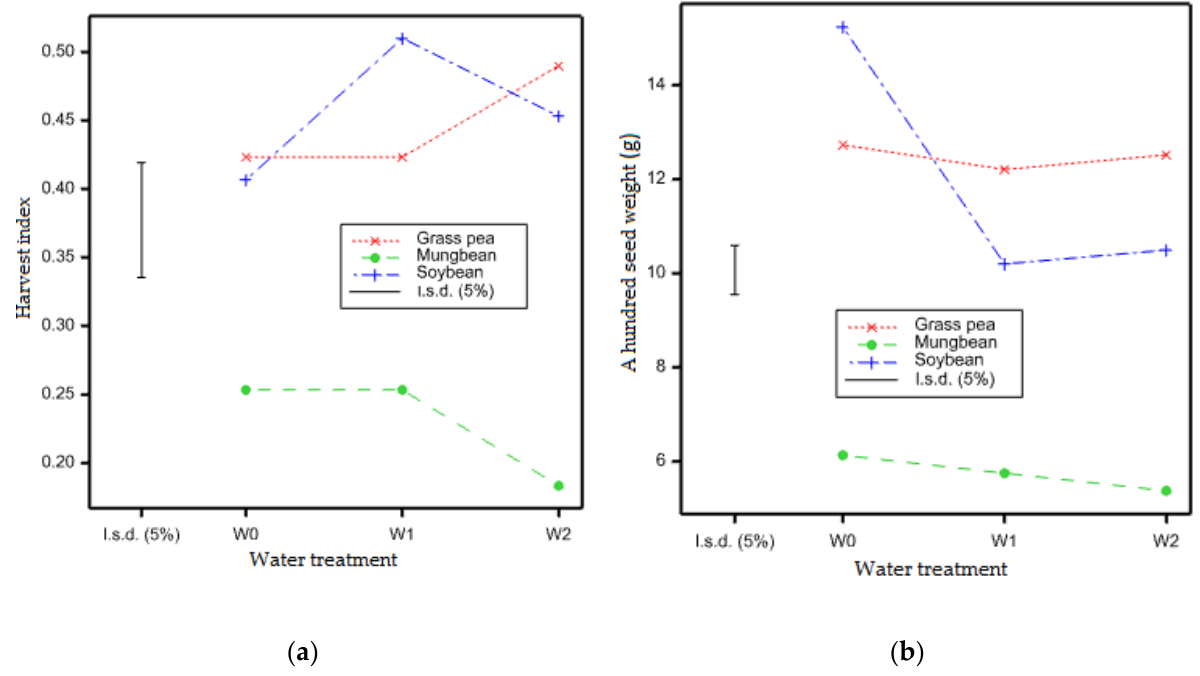
Figure 7. Water treatment × species interaction for ( a ) harvest index ( p = 0.044) and ( b ) 100 seed weight (g) ( p < 0.001) at the Vemase site in 2018.